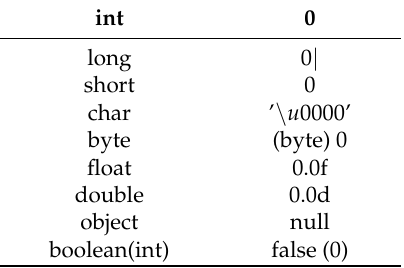
Table 4. Default values of primitive